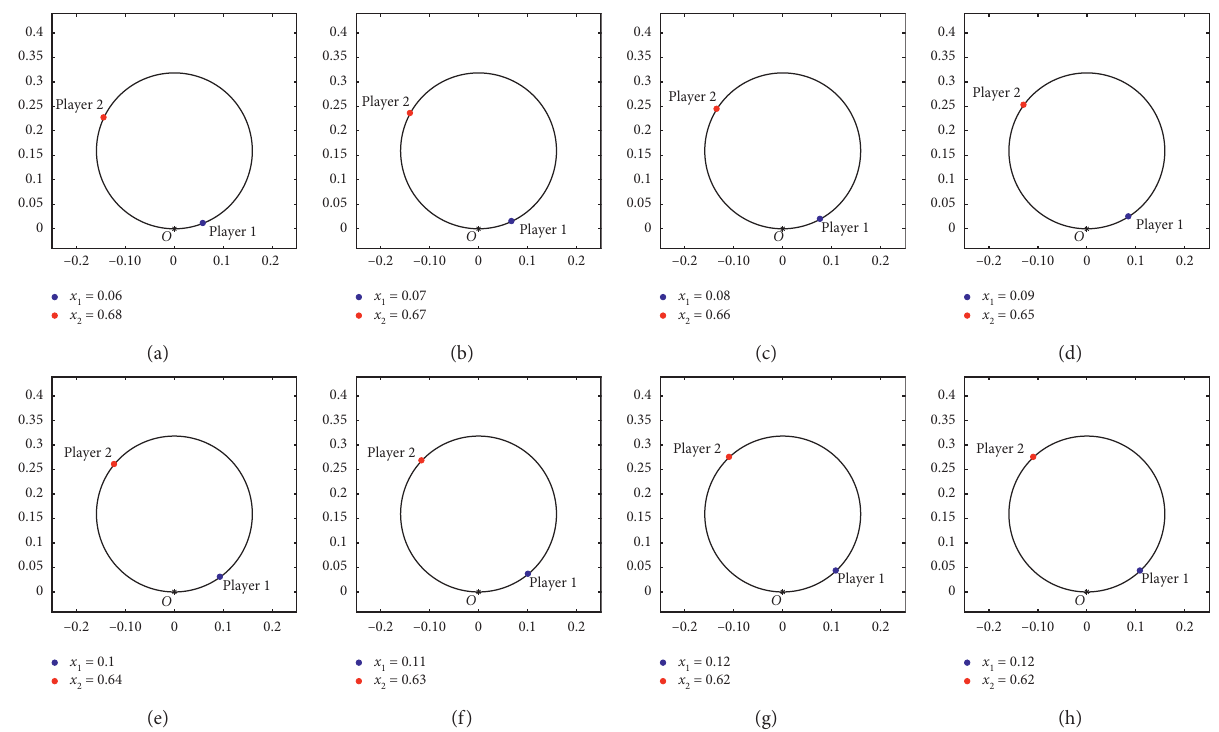
Figure 5: Dynamic evolution of the two-player location game in the closed-loop market with initial positions x